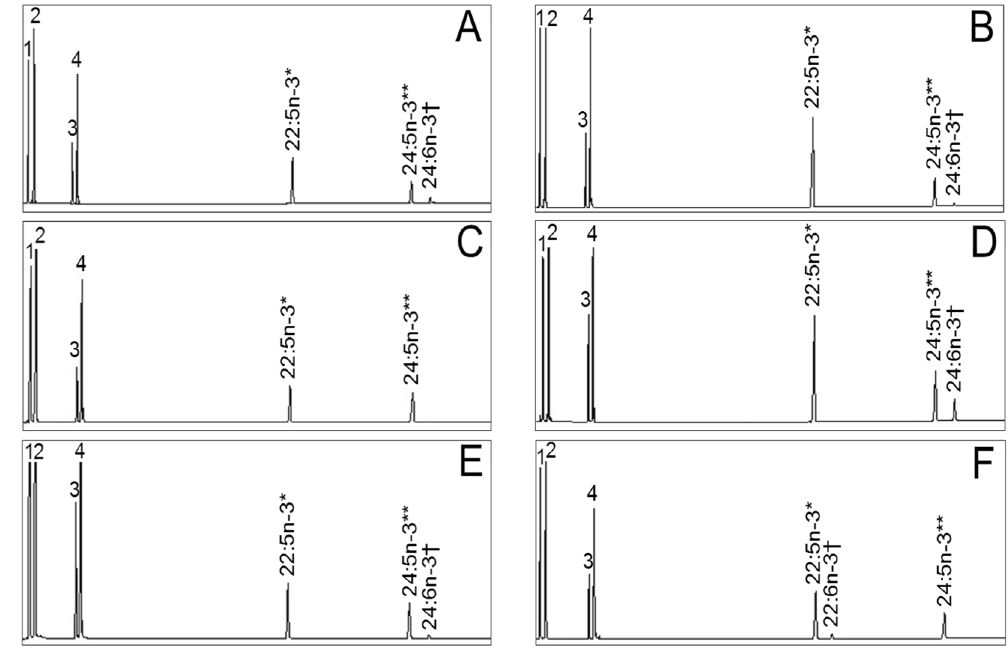
Figure 2. Characterisation of fish fatty acyl desaturases 2 (Fads2) ability to desaturate 24:5n − 3. Fatty acid (FA) profiles of yeast ( Saccharomyces cerevisiae ) co-transformed with the Danio rerio elovl2 , and the Arapaima gigas ∆ 6 fads2 ( A ), Sparus aurata ∆ 6 fads2 ( B ), Nibea mitsukurii ∆ 6 fads2 ( C ), Clarias gariepinus ∆ 6 ∆ 5 fads2 ( D ), Salmo salar ∆ 5 fads2 ( E ) and Chirostoma estor ∆ 4 fads2 ( F ) and grown in the presence of an exogenously added FA substrates (indicated as “ * ” in all panels). Peaks 1–4 represent the S. cerevisiae endogenous FA, namely 16:0